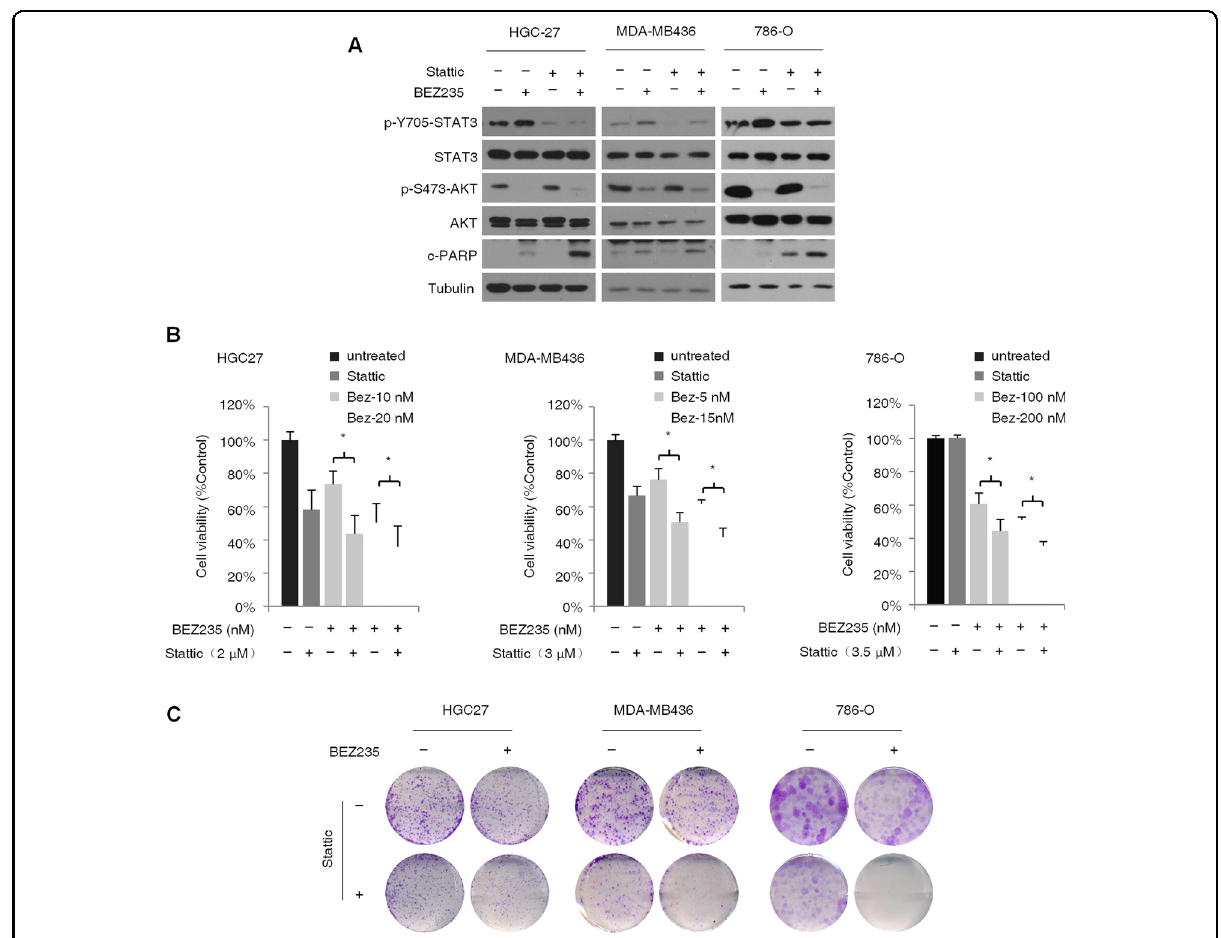
Fig. 5 Simultaneous inhibition of PI3K/mTOR and STAT3 activity shows synergistic inhibitory effect on PTEN-de fi cient cancer cells. A Immunoblot showing expression levels of p-STAT3, T-STAT3, p-AKT, T-AKT, and c-PARP in HGC-27, MDA-MB-436, and 786-O cells treated with BEZ235 (100nM) and/or Stattic (5 μ M) for 24 h. B Percentage of viable HGC-27, MDA-MB-436, and 786-O cells treated with indicated concentration of BEZ235 and/or Stattic for 72 h. Error bars represent means ± SD from triplicates. * P < 0.05. C Representative pictures showing crystal violet-stained colonies formed by the HGC-27, MDA-MB-436, and 786-O cells treated with BEZ235 and/or Stattic for 14